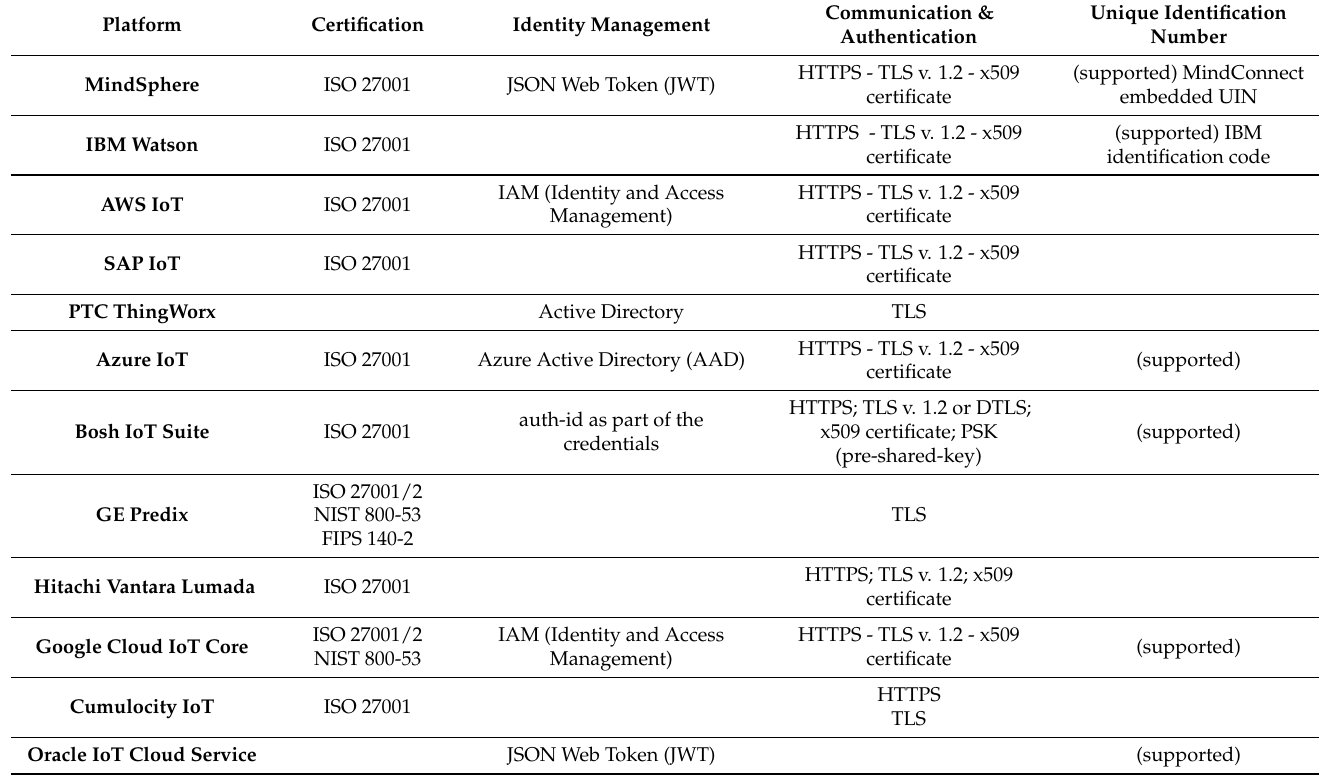
Table 2. Security